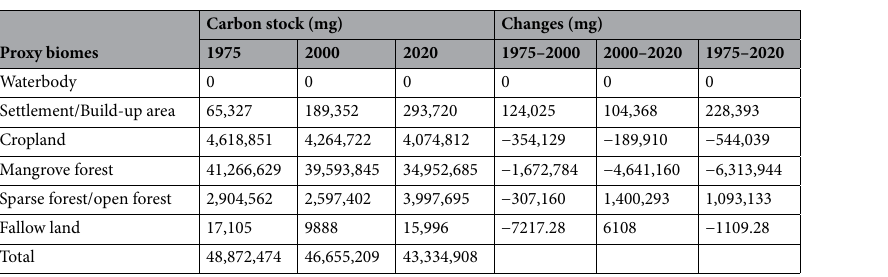
Table 4. Total amount of stored carbon along with change dynamic in SBR